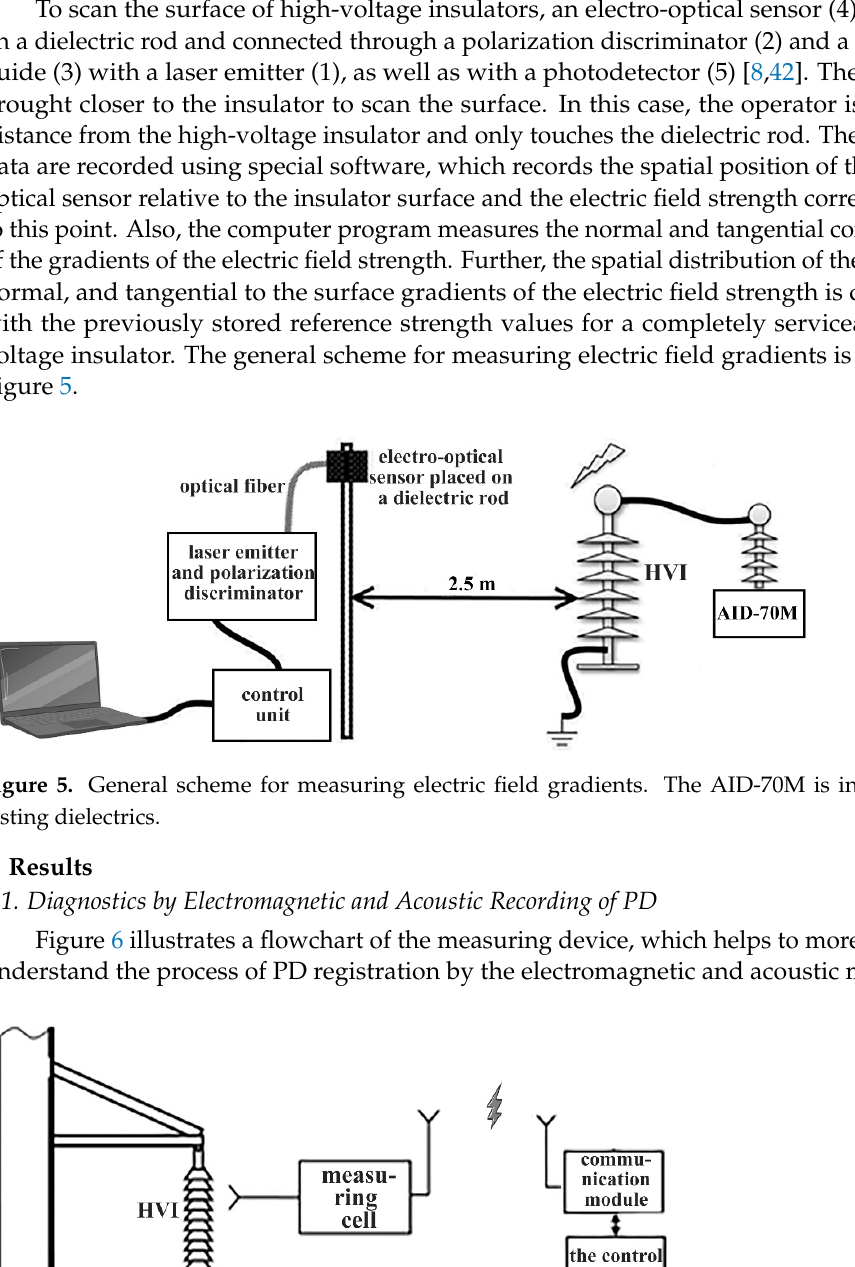
Figure 4. Flowchart of the device.